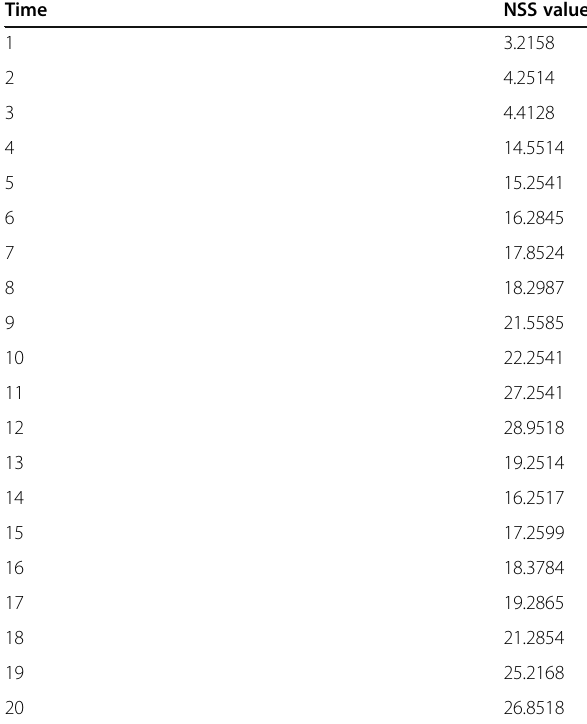
Table 1 NSS values within 20